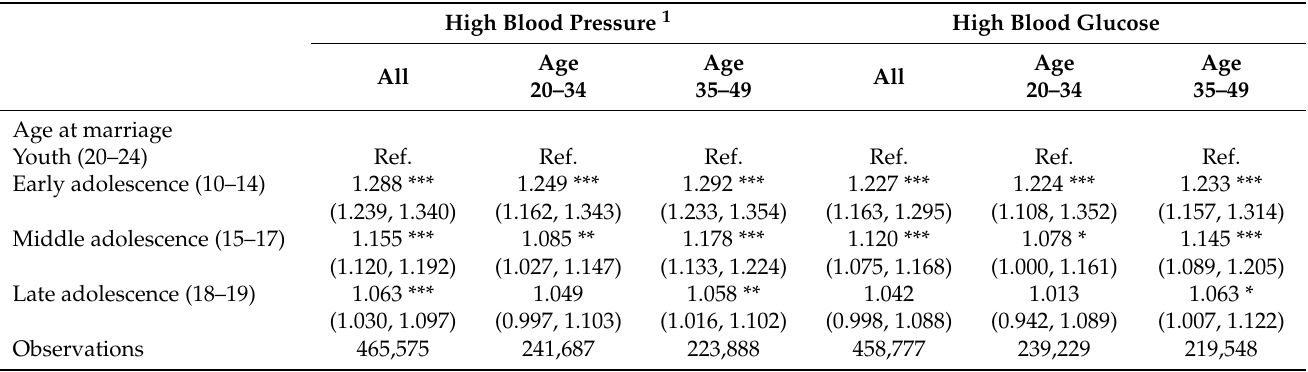
Table 3. Adjusted odds ratios in favor of having high blood pressure and high blood glucose by age at marriage.